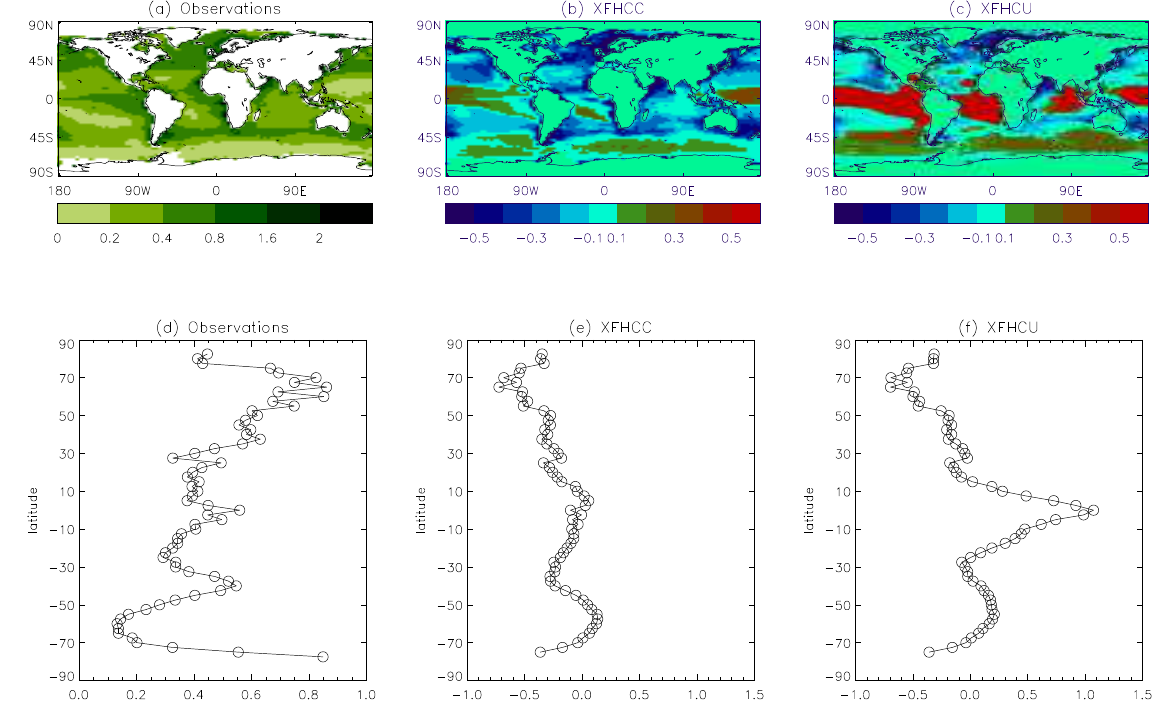
Fig. 18. (a) Observed primary production (Behrenfeld and Falkowski, 1997) and (b–c) difference between the generation 3 model XFHCC and the generation 4a model XFHCU and observational data. Sub-figures (d–f) show the same data but for zonally averaged quantities. The units of all quantities in this figure are gC per m 2 per